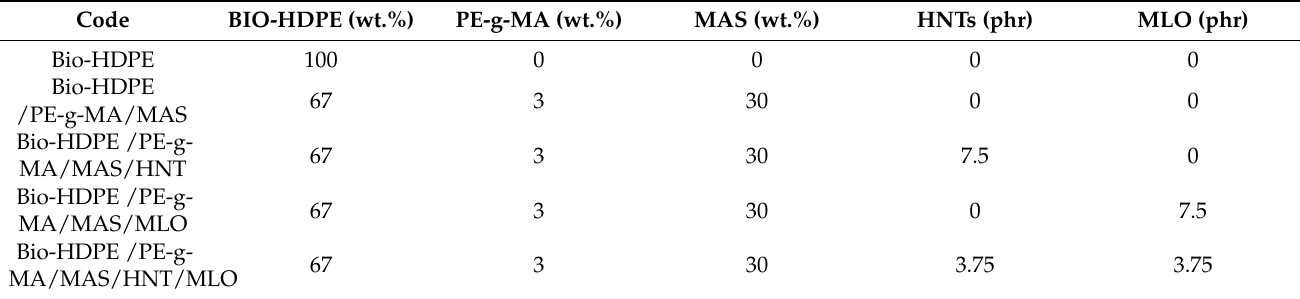
Table 1. Summary of compositions according to the weight content (wt.%) of Bio-HDPE/MAS and different compatibilizers and additives. Code BIO-HDPE (wt.%) PE-g-MA